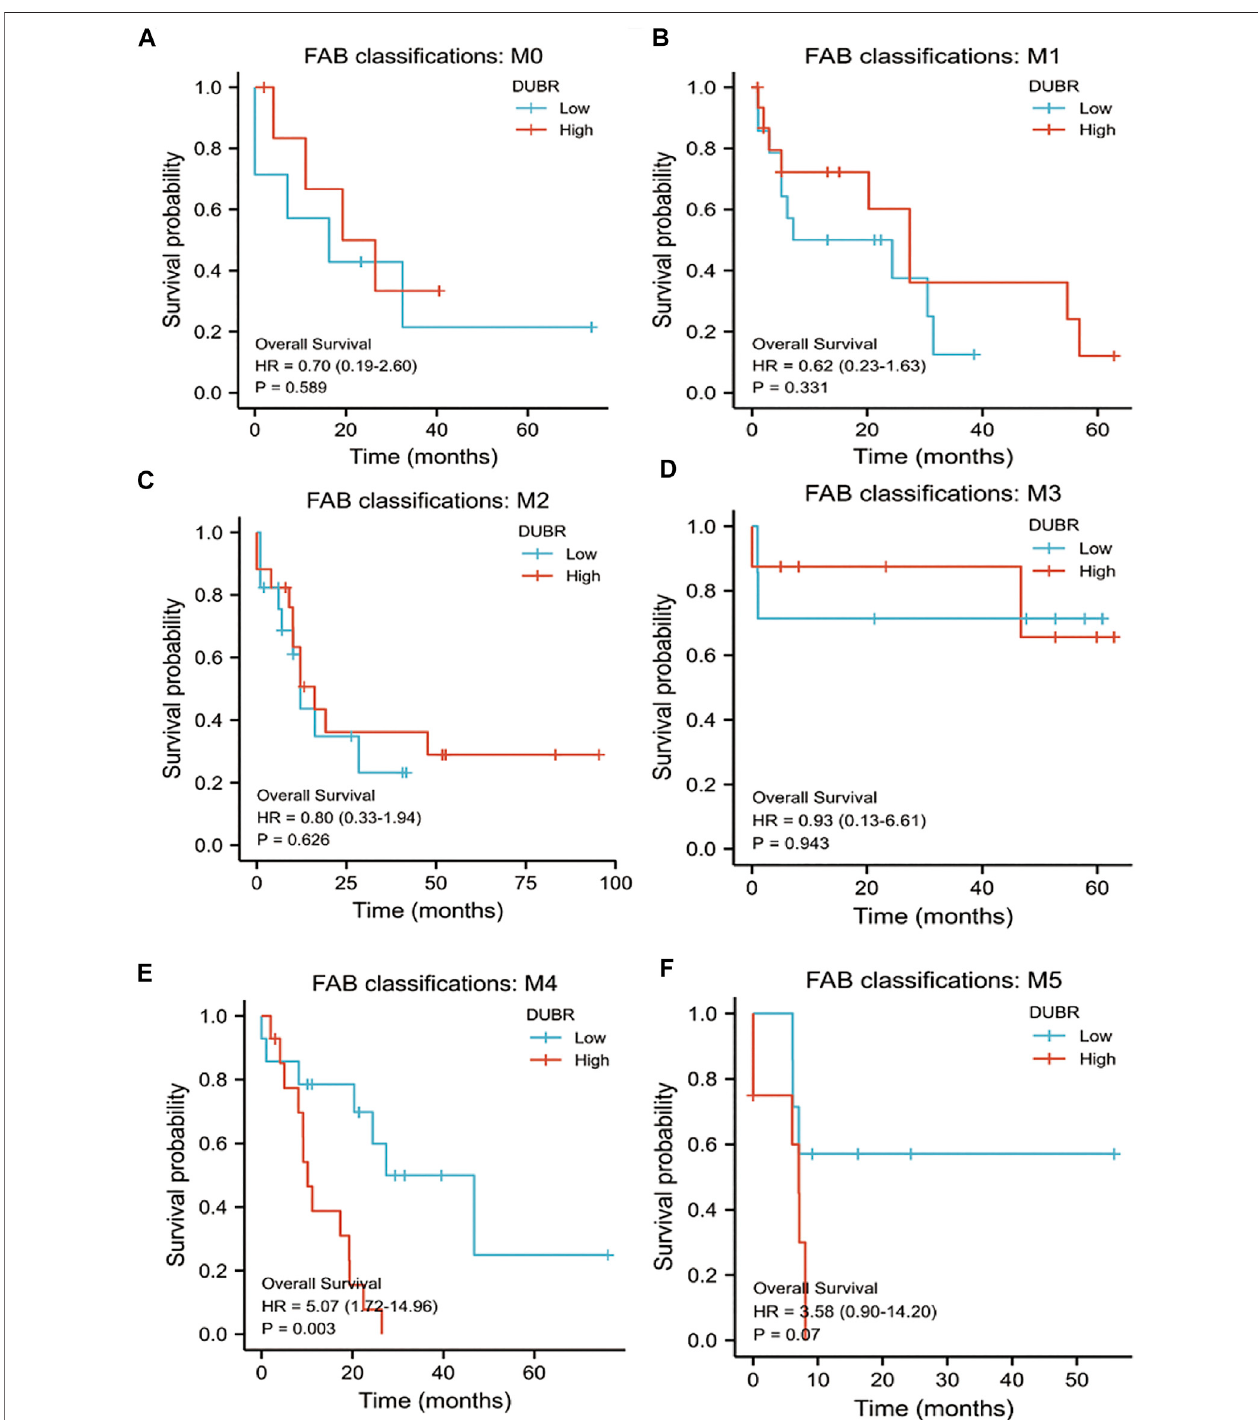
FIGURE 3 | K-M survival analysis to compare DUBR up-regulation and down-regulation within diverse FAB classi fi cation types of AML in Kaplan-Meier Plotter by GEPIA database. (A) M0; (B) M1; (C) M2; (D) M3; (E) M4; (F) M5.